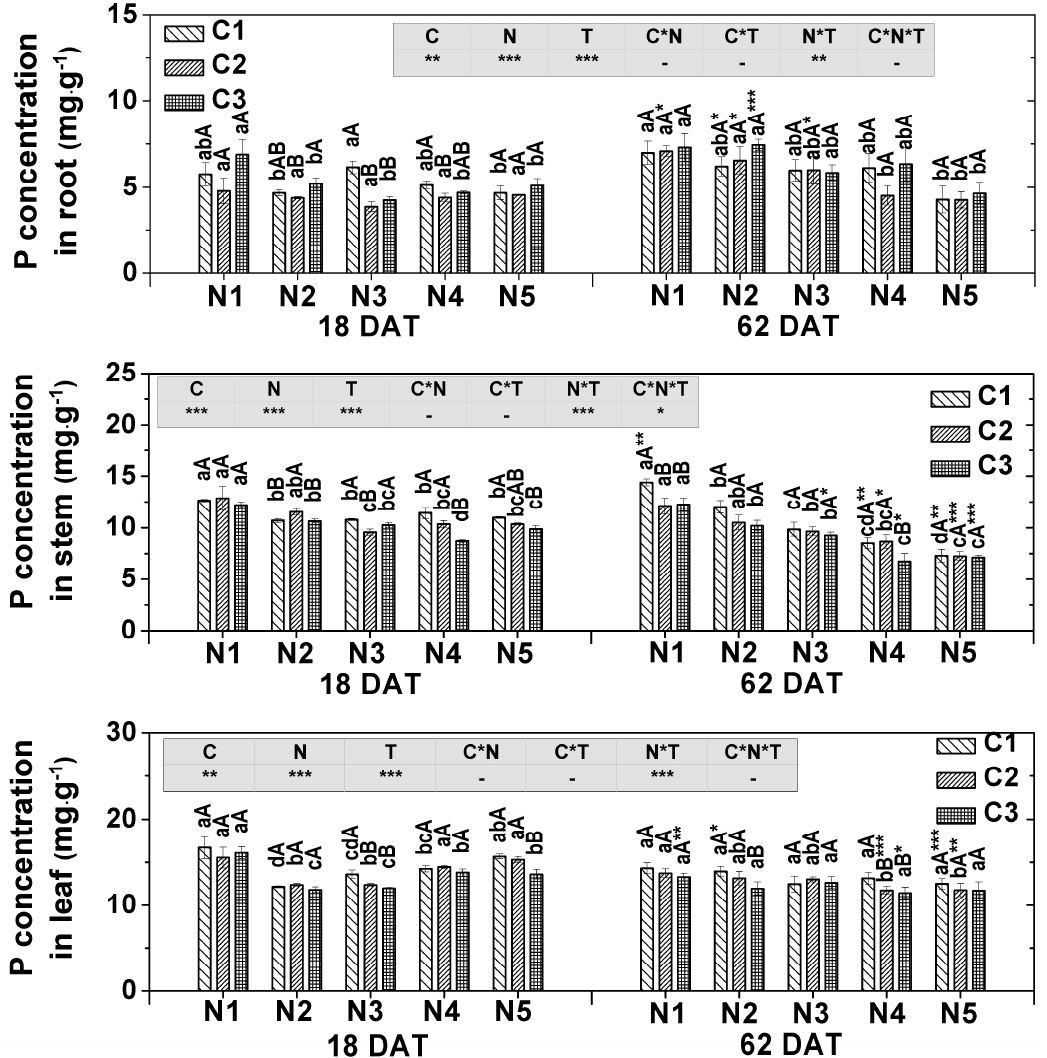
Figure 3. Phosphorus concentrations in different tissues of cucumber plants grown under different N and [CO 2 ] levels at two growth stages ( n = 6). Bars represent standard errors. CO 2 levels: C1, C2, and C3: 400, 625, and 1200 μ mol mol − 1 . N levels: N1, N2, N3, N4, and N5: 2, 4, 7, 14, and 21 mmol L − 1 . Means not followed by the same lower case letters are significantly different among different N levels in the same CO 2 level and growth stage, and not followed by the same upper case letters are significantly different among different CO 2 levels in the same N level and growth stage, according to Duncan’s test at p < 0.05. Means with asterisks are significantly different between two growth stages in the same CO 2 and N level (* p < 0.05; ** p < 0.01; *** p < 0.001). In the internal table, C: [CO 2 ] level; N: N level; T: growth stage. Asterisks (*) indicate significant differences (* p < 0.05; ** p < 0.01; *** p < 0.001); - indicates non-significant differences ( p ≥ 0.05).